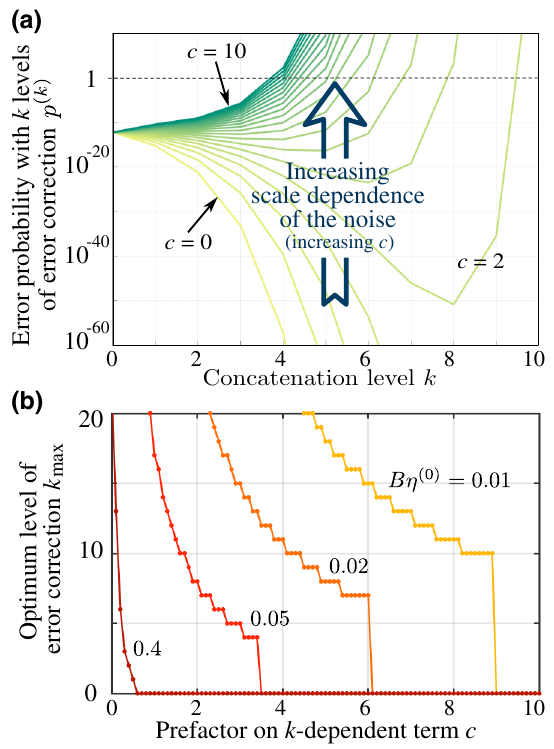
FIG. 4. (a) An example of how p ( k ) varies as the concatenation level k increases, for the affine model with c = 0 (lightest color), 0.5, 1, . . . , 10 (darkest color), B = 10 4 , and η ( 0 ) = 5 × 10 − 6 , for which B η ( 0 ) = 0.05, far below the threshold for c = 0. All curves, apart from that for c = 0, turn around for large enough k . (b) The maximum k value, k max , such that p ( k + 1 ) < p ( k ) , with p ( 0 ) ≡ η ( 0 ) , the unencoded error probability, for different val- ues of B η ( 0 ) < 1 and c ∈ { 0, 0.1, 0.2, . . . , 10 } . In every case, k max eventually falls to zero for large enough c , i.e., it is better to have no